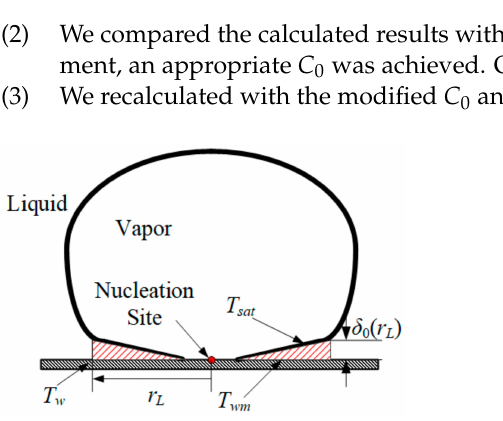
Figure 1. Schematic of the micro-layer.